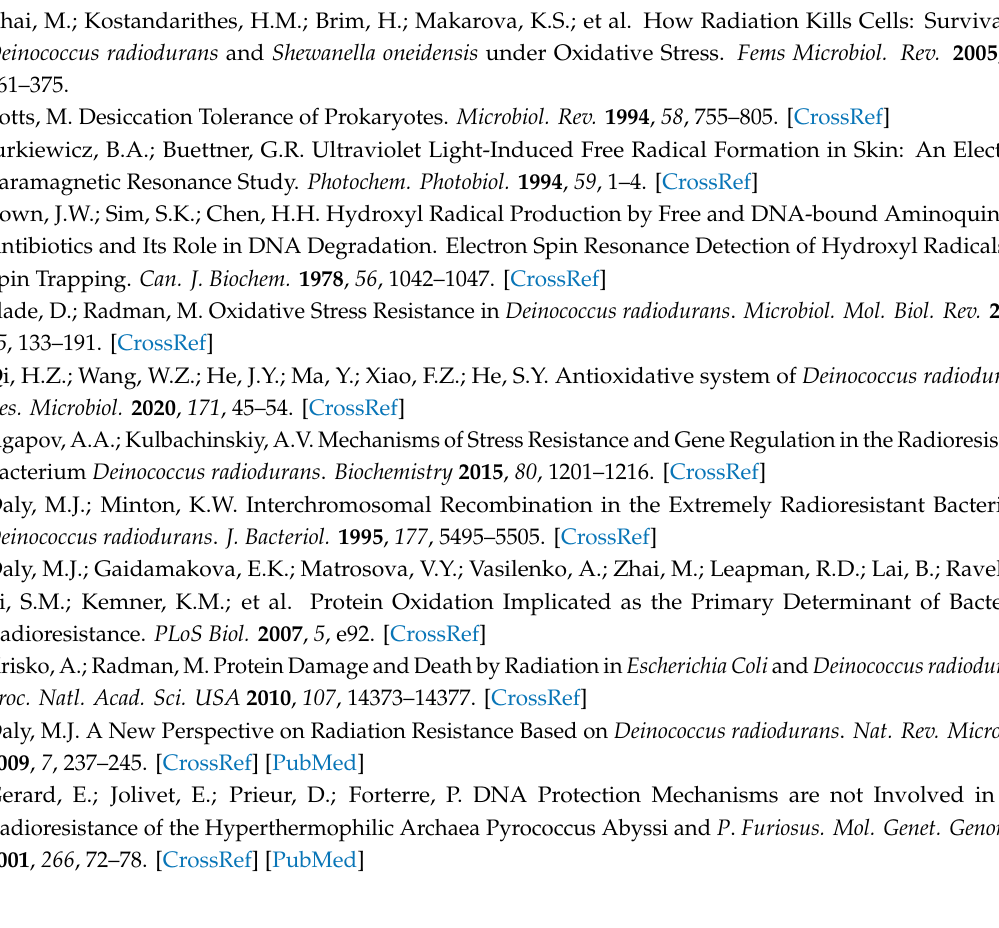
Figure S1: Di ff erential expression levels between two groups of samples (DC and DH), Figure S2: KEGG biological pathway classification of di ff erentially expressed proteins in D. radiodurans with and without oxidative stress, Figure S3: COG functional classification analysis of all the di ff erential proteins in DH versus DC. Table S1: List of primers used for qRT-PCR in this study, Table S2: List of node degree of each protein in